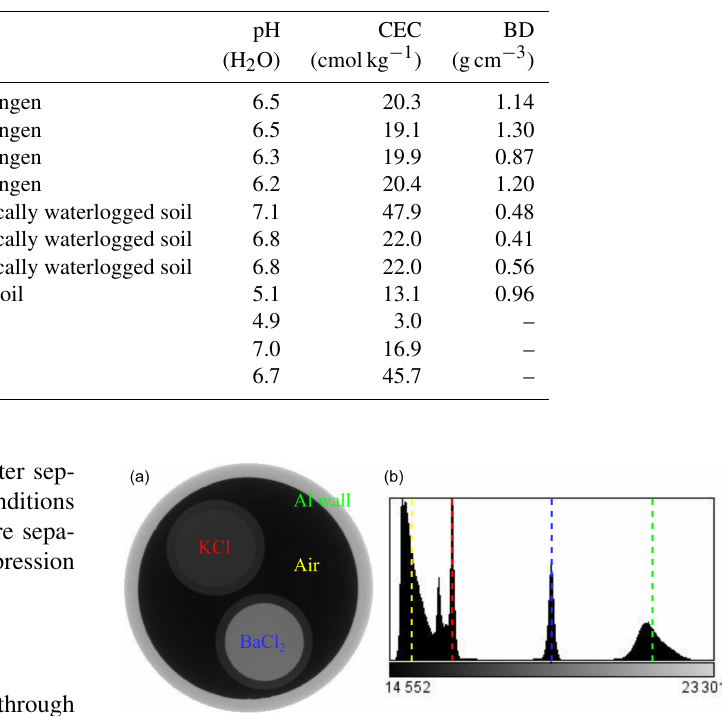
Figure 1. (a) Contrast image of the aluminium cylinder wall, KCl and BaCl 2 solution and the air. (b) The corresponding histogram with the mean values for the aluminium cylinder wall (green), KCl (red) and BaCl 2 (blue) solution and the air (yellow) indicated as dotted